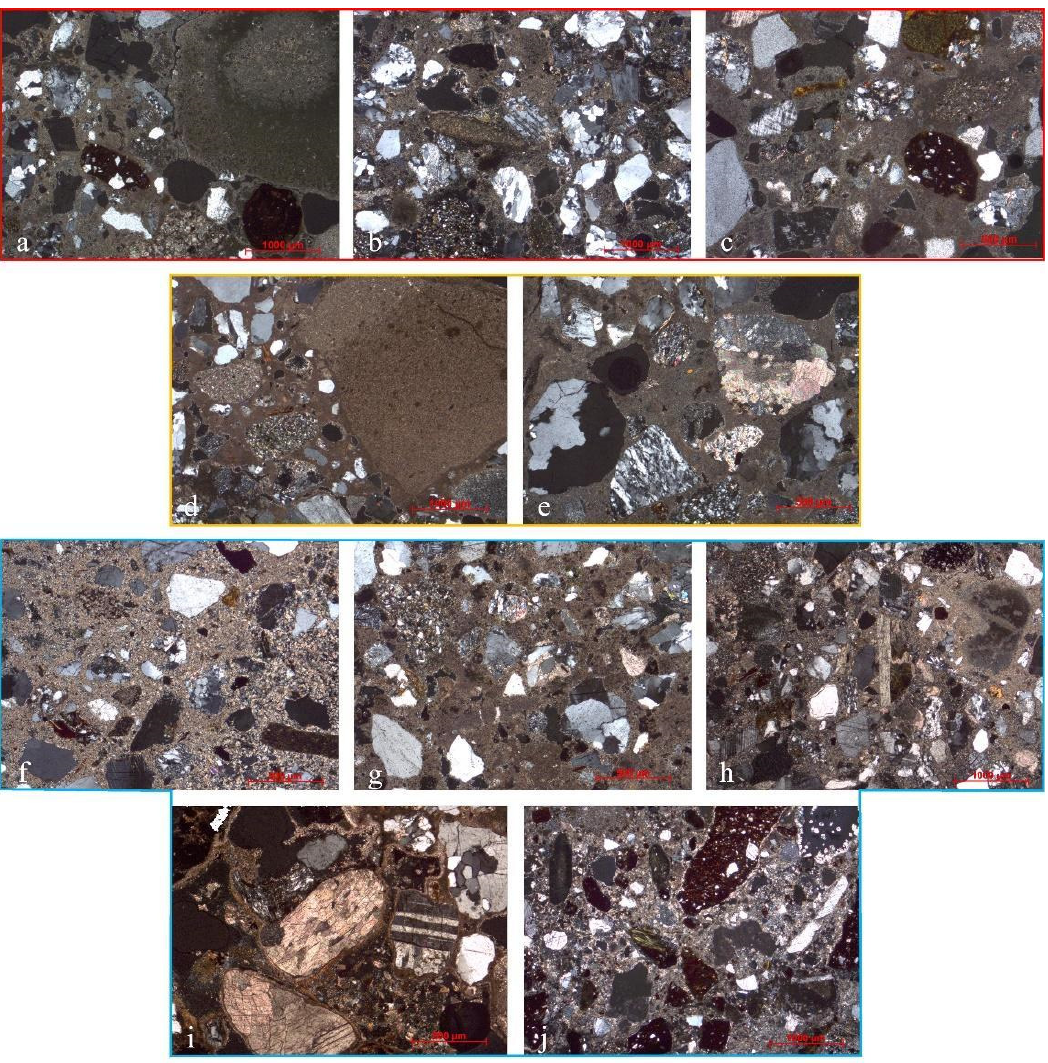
Figure 9. Microphotograph of thin sections of some selected mortar samples: ( a ) S1, ( b ) S2, ( c ) S3, ( d ) S5 (12–26) cm, ( e ) S5 (26–38) cm, ( f ) S13, ( g ) S14, ( h ) S7, ( i ) S6 and ( j ) S12 (by polarized optical microscopy; crossed nicols).